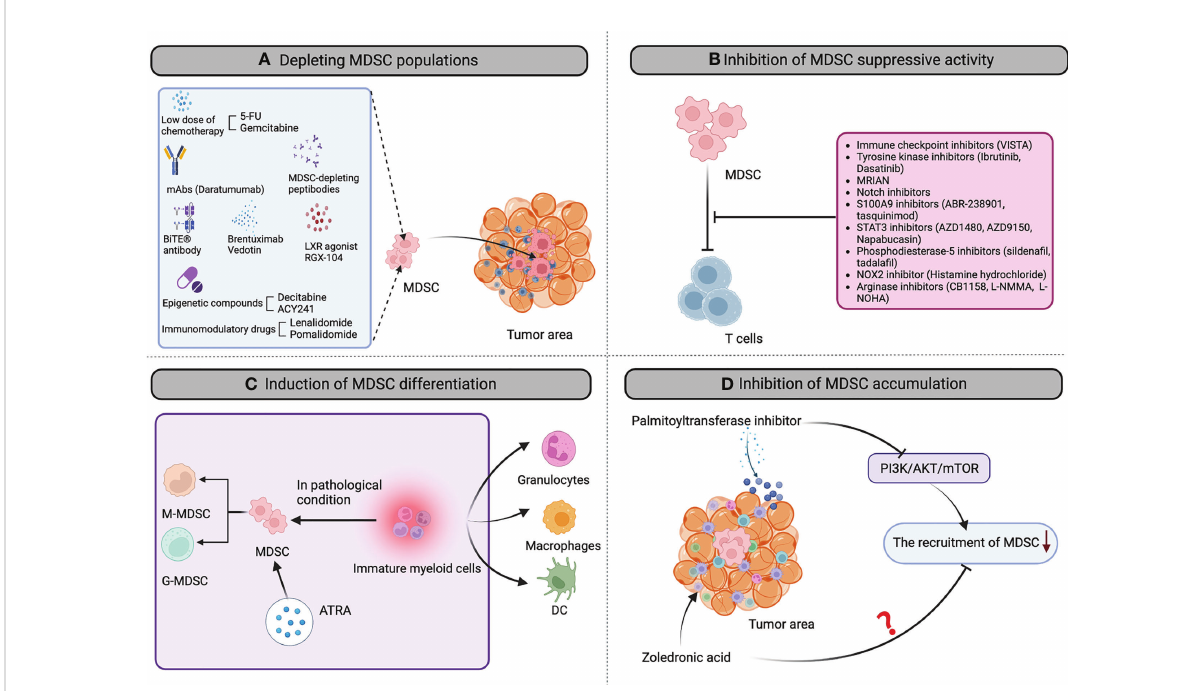
FIGURE 1 The landscape of MDSC-targeting strategies in hematological cancers. Multiple MDSC-targeting approaches were evaluated in hematological cancers to restore the anti-tumor immune response, including: (A) depleting MDSC populations through low-dose chemotherapy agents, mAbs, peptibodies, brentuximab vedotin, epigenetic compounds, CD33/CD3-bispeci fi c T-cell engaging (BiTE ® ) antibody, LXR agonist RGX-104, Immunomodulatory drugs et al; (B) attenuating the immunosuppressive mechanisms of MDSC by immune checkpoint inhibitors, tyrosine kinase inhibitors, MRIAN, notch inhibitors, S100A9 inhibitors, STAT3 inhibitors, phosphodiesterase-5 inhibitors, histamine hydrochloride; arginase inhibitors; (C) inducing the differentiation of MDSC into mature myeloid cells by all-trans-retinoic acid (ATRA) to reduce MDSC population and remove their immunosuppression; (D) inhibiting MDSC accumulation in the tumor microenvironment by palmitoyltransferase inhibitor and zoledronic acid. mAb, monoclonal antibody; BiTE, bi-speci fi c T-cell engagers; 5-FU, 5- fl uorouracil; LXR, activation of liver X receptor; STAT3, signal transducer and activator of transcription 3; NOX2, NADPH oxidase 2; ATRA, all-trans-retinoic acid; DC, dendritic